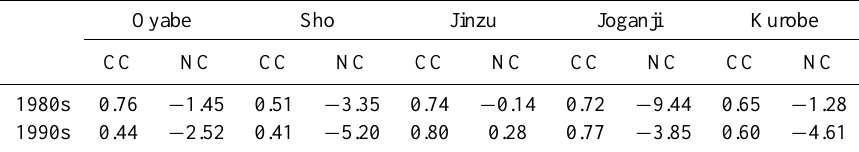
Table 3. Correlation coefficients (CC) and Nash-Sutcliffe efficiency coefficients (NC) of monthly mean discharges for the five rivers in the 1980s and